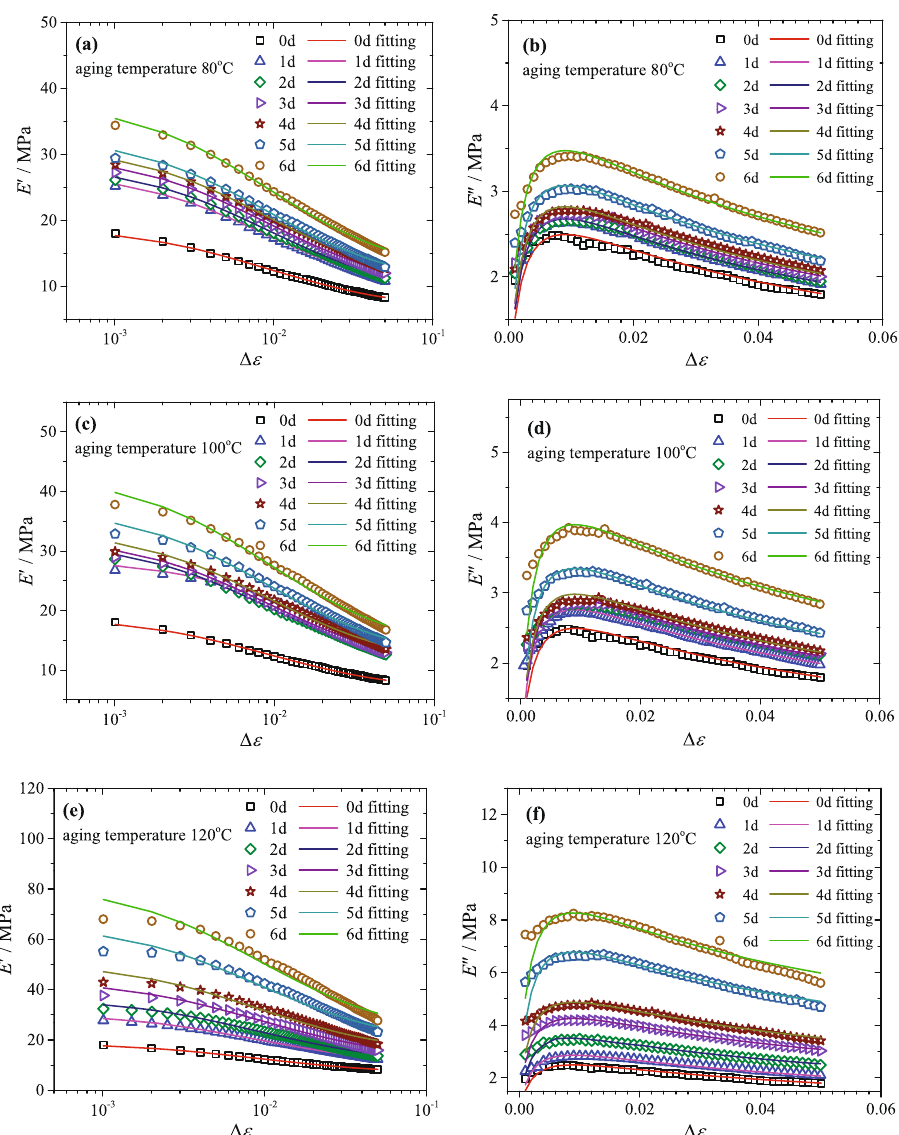
Fig. 2 Dynamic mechanical modulus vs. strain amplitude. Scatters are the experemental resutls for various aging times and temperatures, and solid lines are the modelling results. a , b The storage modulus and the loss modulus respectively for aging temperature 80 °C, c , d the storage modulus and the loss modulus respectively for aging temperature 100 °C, e , f the storage modulus and the loss modulus respectively for aging temperature 120